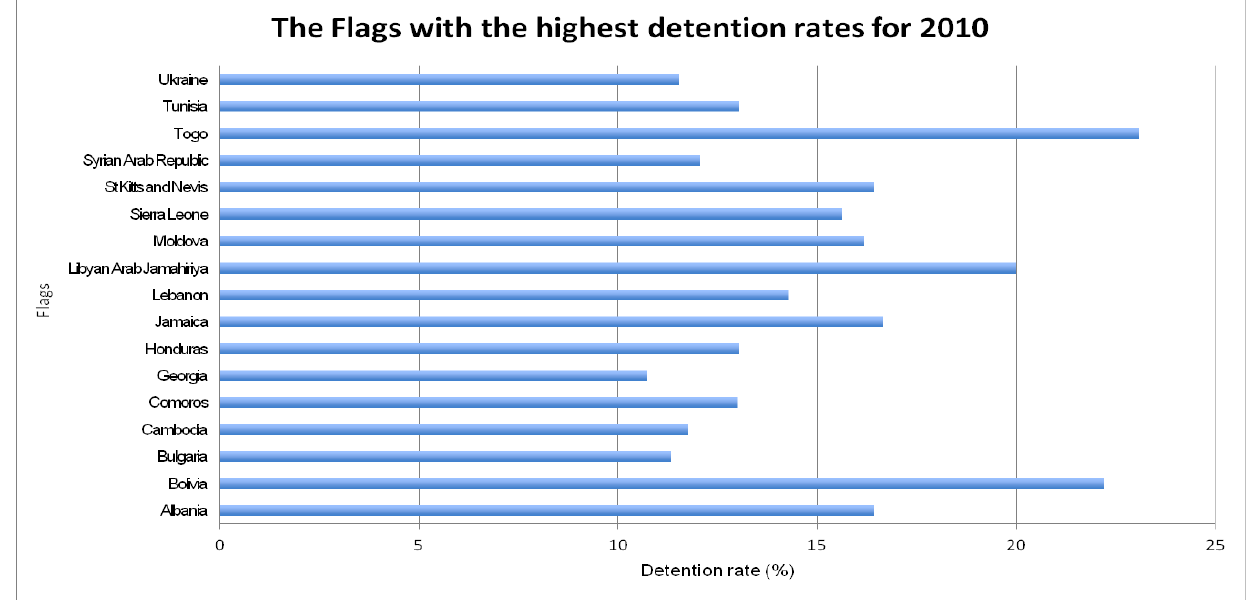
Graph 9D: Flags with the highest detention rates for 2010